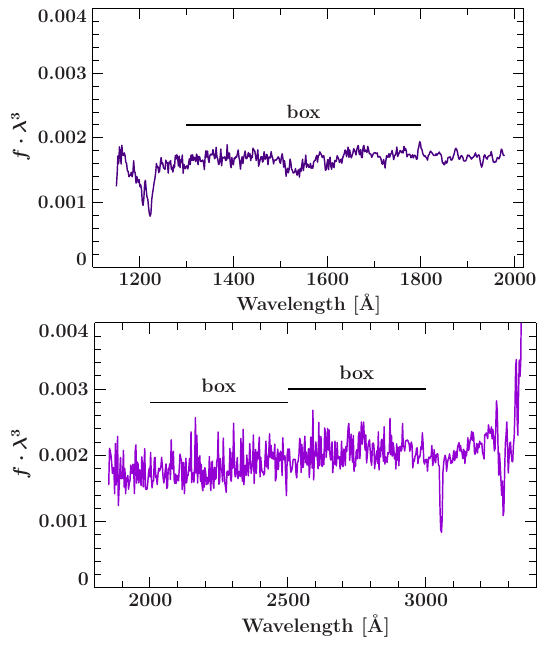
Figure 2. Box filters to convert IUE low resolution spectra to UV magnitudes. One box is placed in the wavelength range covered by the short wavelength camera (SWP, upper panel) and two in the regime covered by the long wavelength cameras (LWR/LWP, lower panel).